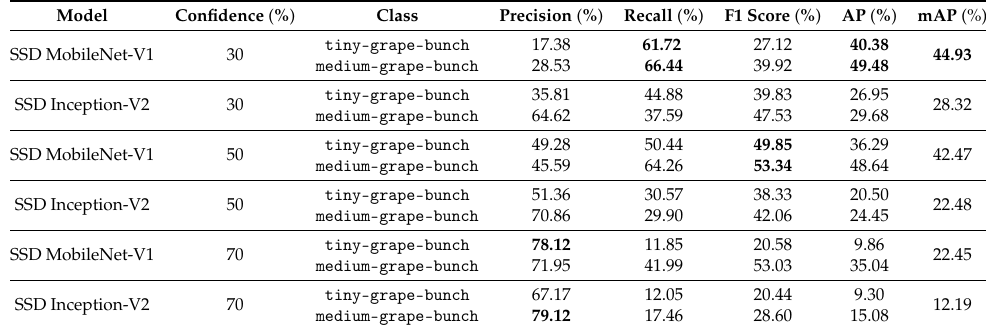
Table 4. Grape bunch detection performance considering an IoU of 50% and a variation of the confidence threshold for three different